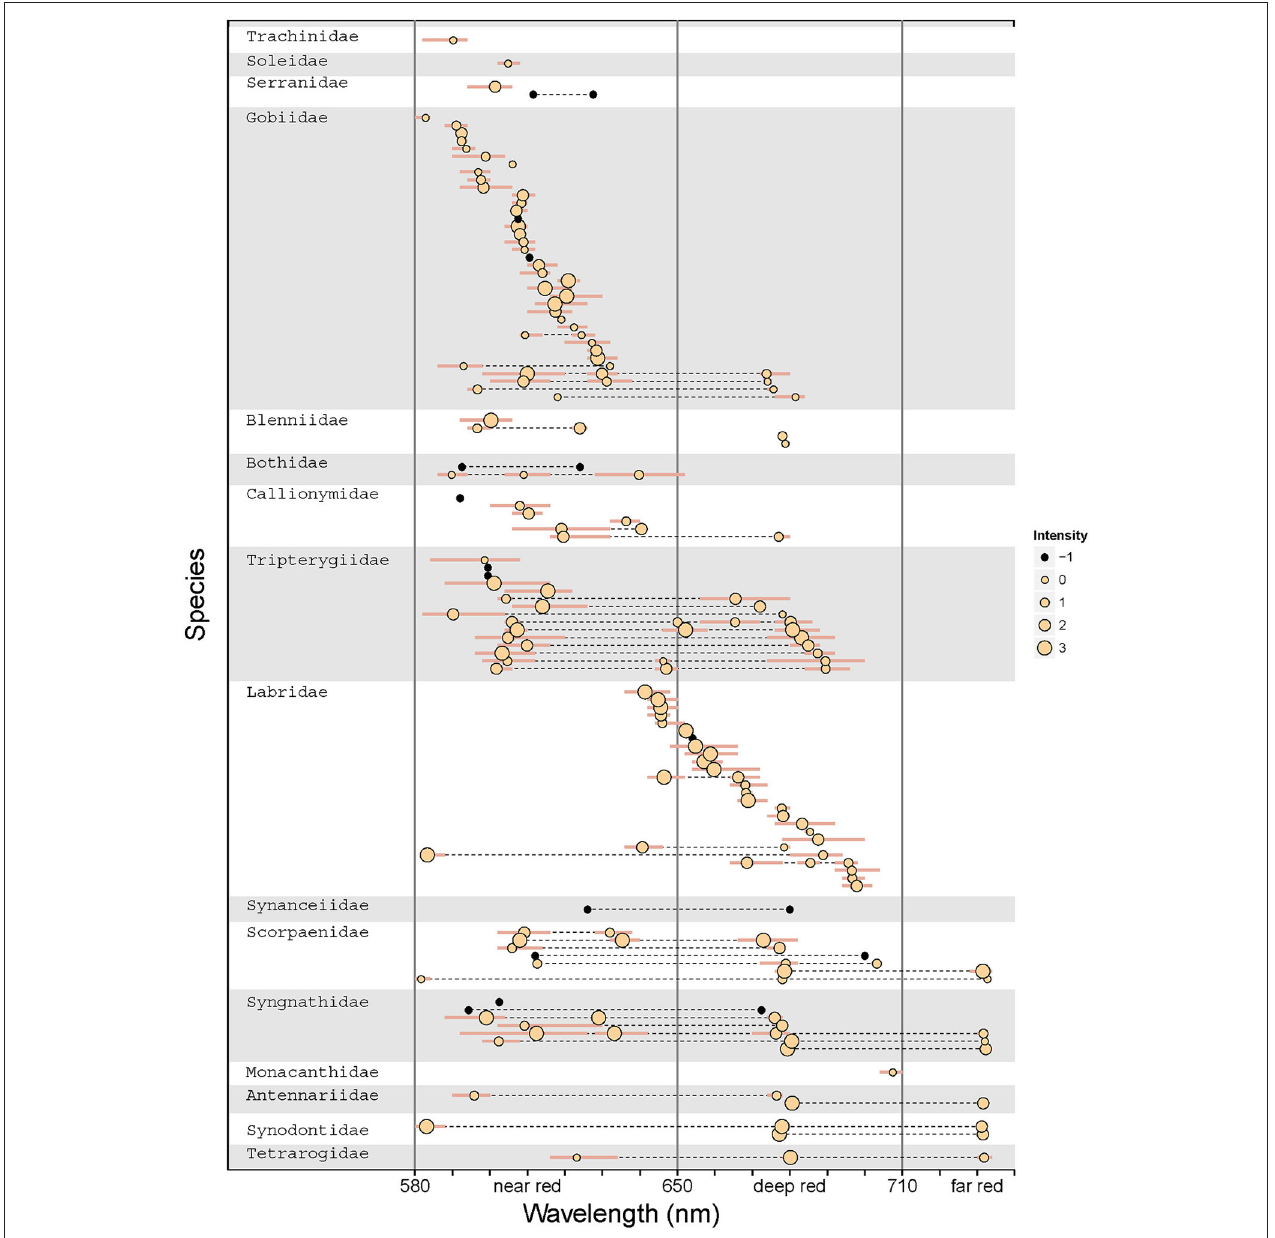
FIGURE 9 | Species- and family-level patterns of fluorescence peak emissions and intensity. The graph indicates the λ max for each emission peak for all 114 measured species, with inter-individual range shown as bars. Multiple λ max values per species are connected by a dotted line. Dot size indicates fluorescence intensity in four intensity quartiles per measurement campaign. Black dots show emission peaks from data sets for which comparable brightness measures were unavailable. Vertical lines separate the data into near red, deep red, and far red fluorescence (cf. Figure 6 ). Families and species are ordered by average peak